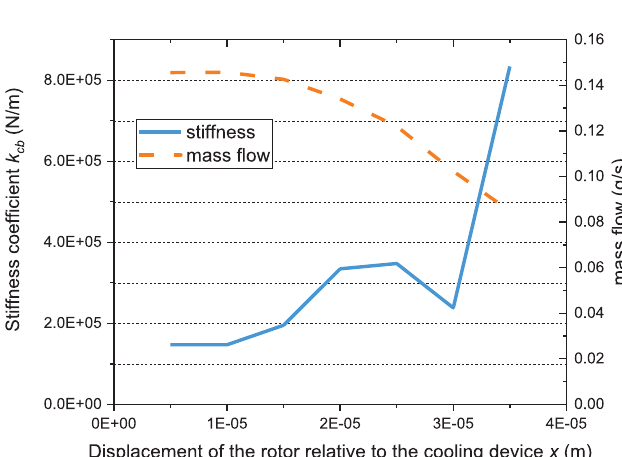
Fig. 9. Three-dimensional fi nite element model of the rotor system.